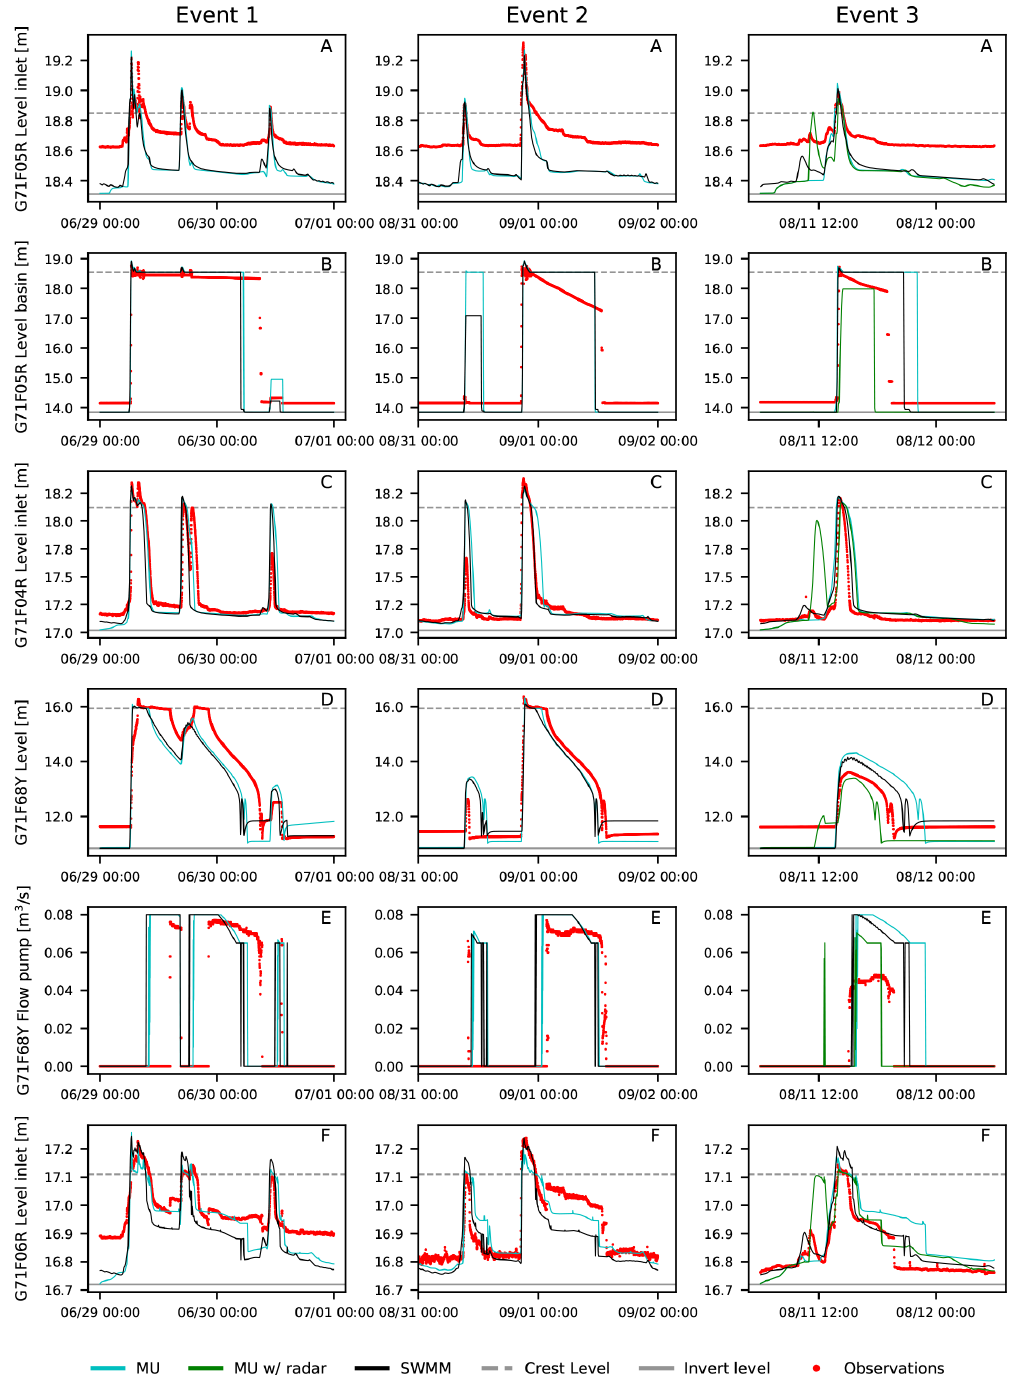
Figure 11. Computed time series of level and flow using MU (cyan) and SWMM (black) compared with observations (dotted red) for the sensors in and around the storage pipe in Bellinge. Dashed grey horizontal lines indicate weir crest levels. The green time series for event 3 is MU with radar input. Note that the vertical axes are not the same for all the rows of the figure. Water level units are metres above sea level (ma . s . l . ), while flow units are m 3 s − 1 .